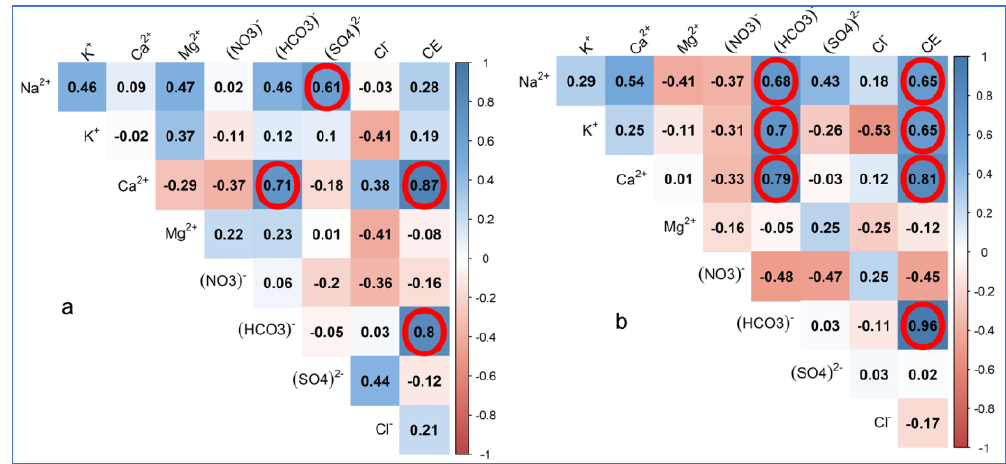
Figure 9. Spearman ’s rho correlation coefficients. Circled values are significant at the 5% level: ( a ) low water, and ( b ) high water.